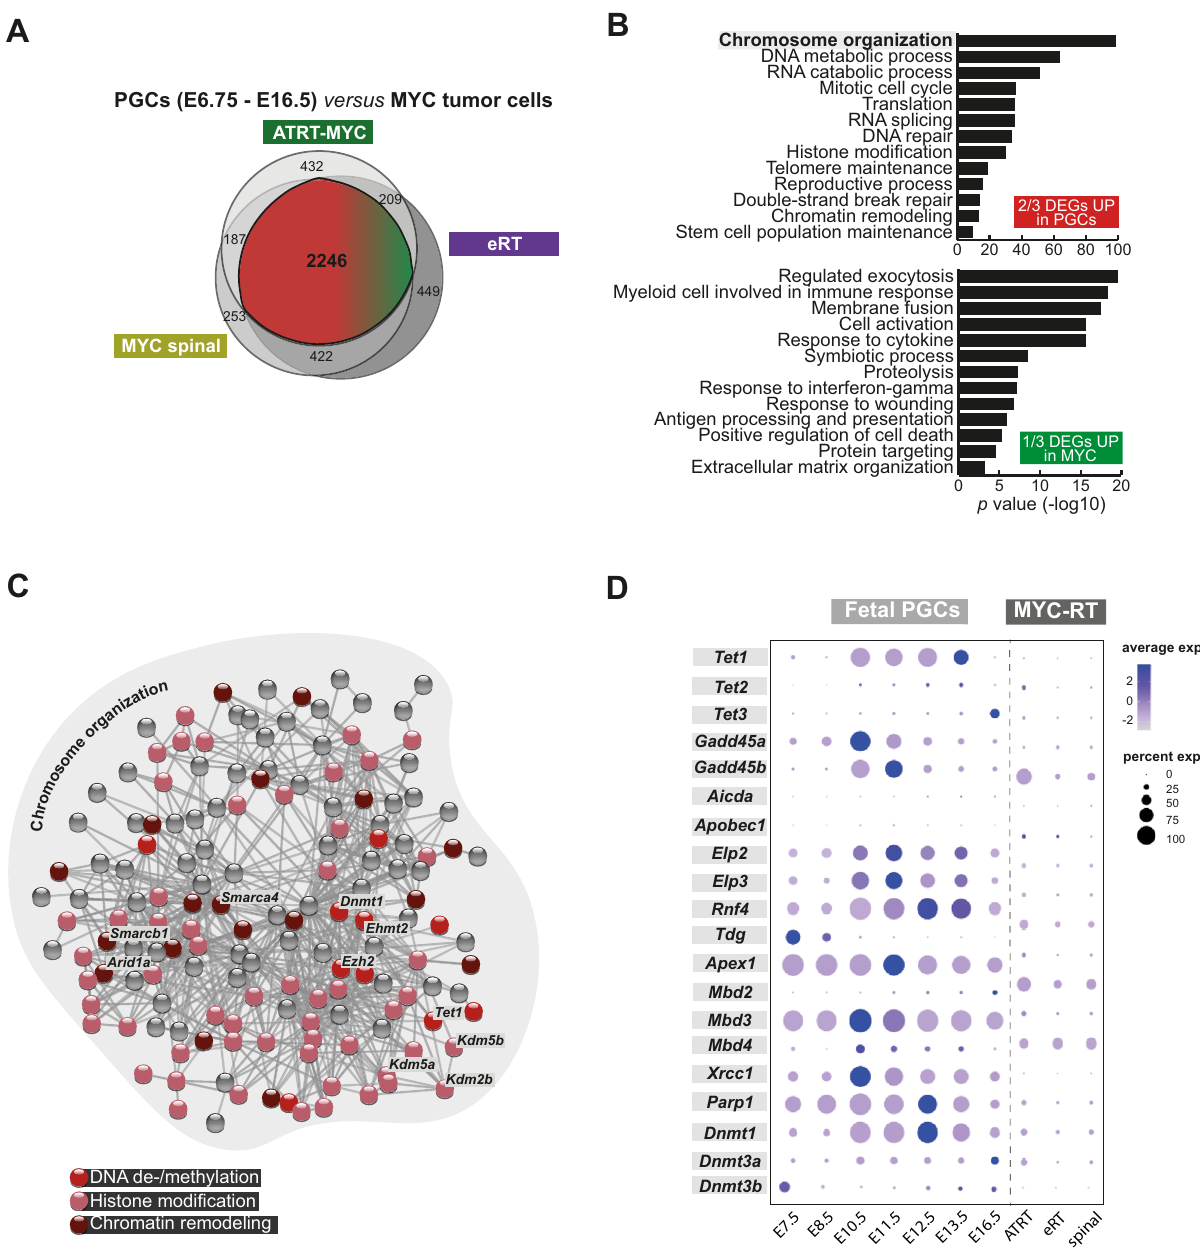
Fig. 5 RT of the MYC subgroup have a deregulated transcriptome and epigenome compared to PGCs. A Venn diagram showing the overlap of DEGs derived from the comparison between PGCs (E6.75 – E16.5) 30,35 and MYC tumor cells of each subtype. Two-thirds of overlapping DEGs are upregulated (in PGCs, in red) and one-third are downregulated (upregulated in tumor cells, in green). B GO term analysis of the overlapping DEGs between PGCs and MYC tumor cells among all subtypes. Only signi fi cantly enriched GO terms were considered ( x -axis, − log10 scale). Differential expression analysis used MAST algorithm 88 . Statistically signi fi cant genes were considered having a q -value < 0.05 (Bonferroni correction). Functional annotation was performed using ToppGene Suite 87 (with statistical method as probability density function) considering GO terms enriched with an adjusted p -value (FDR) < 0.05. C STRING interaction network of shared upregulated DEGs (upregulated by PGCs) related to the GO term annotation ‘ chromosome organization ’ . Each dot represents one gene. Major cellular functions are indicated by different colors and exemplary genes are highlighted. D Dotplot representing the expression of selected epigenetic-related genes in fetal PGCs (E7.5 – E11.5) and the three MYC subtypes (MYC spinal, eRT and ATRT-MYC). See also Supplementary Fig. 11 and source data fi